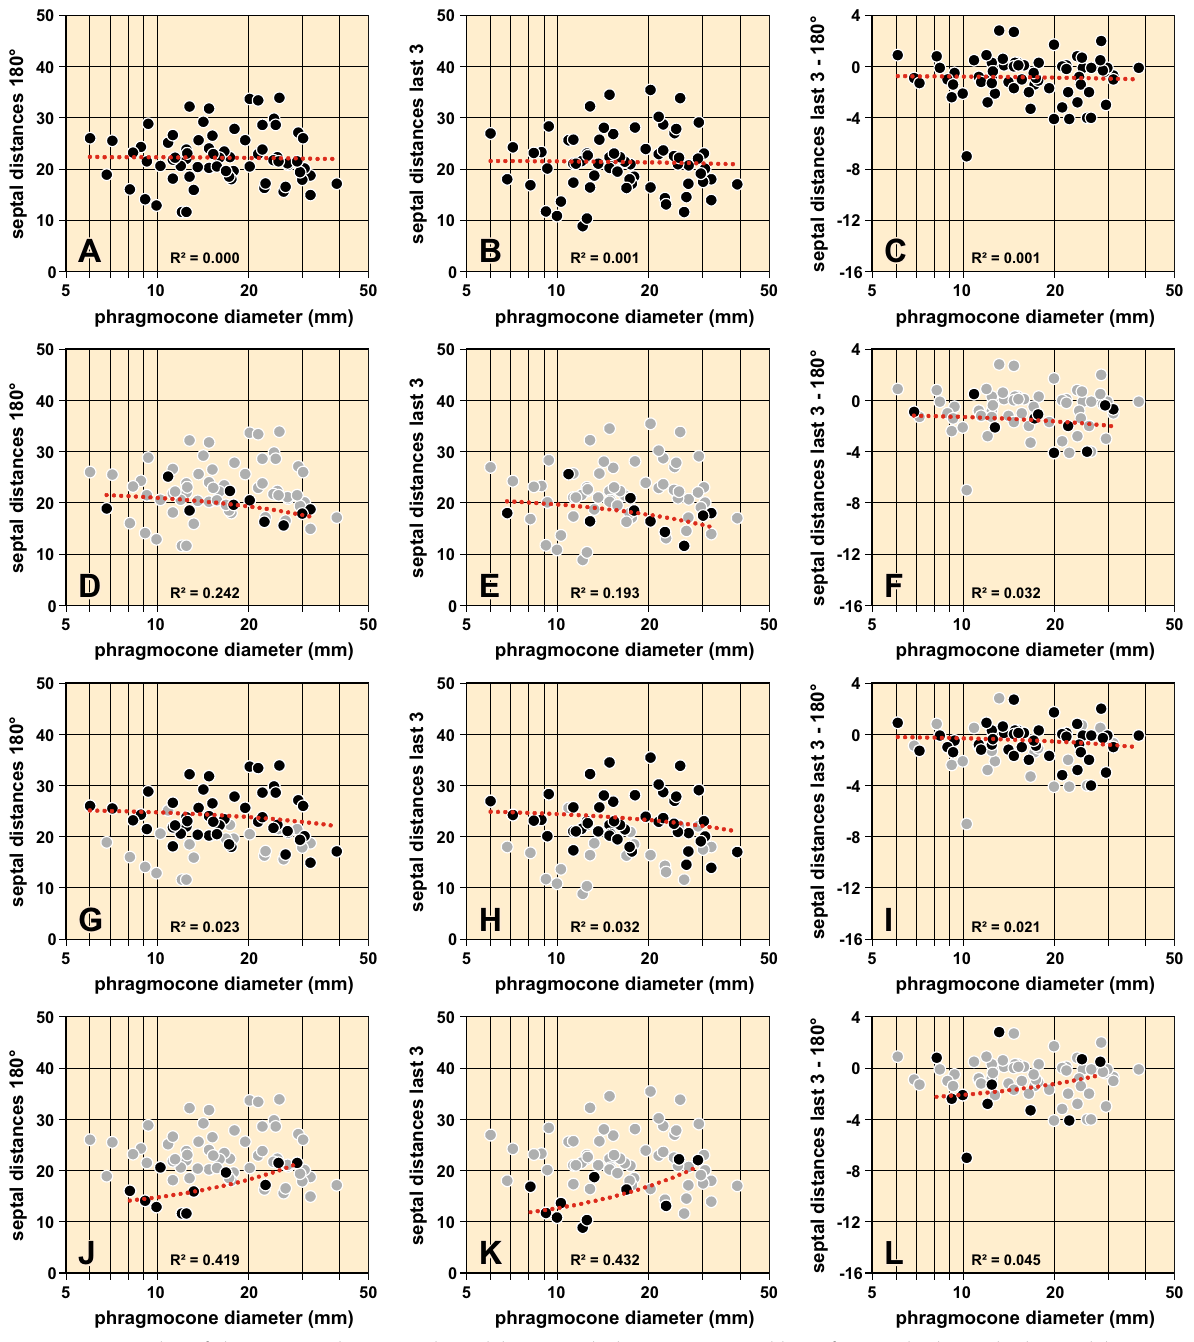
Fig. 13 Bivariate plots of phragmocone diameter and septal distance in the late Givetian assemblage of Hassi Nebech (grey background dots represent the entire sample). A , D , G , J Septal spaces of all septa in the last half volution. B , E , H , K septal distances of the last three septa. C , F , I , L Difference in the septal spaces of the last three septa all septa in the last half volution. A – C Complete assemblage. D – F Suborder Gephuroceratina. G – I Suborder Pharciceratina. J – L Suborder